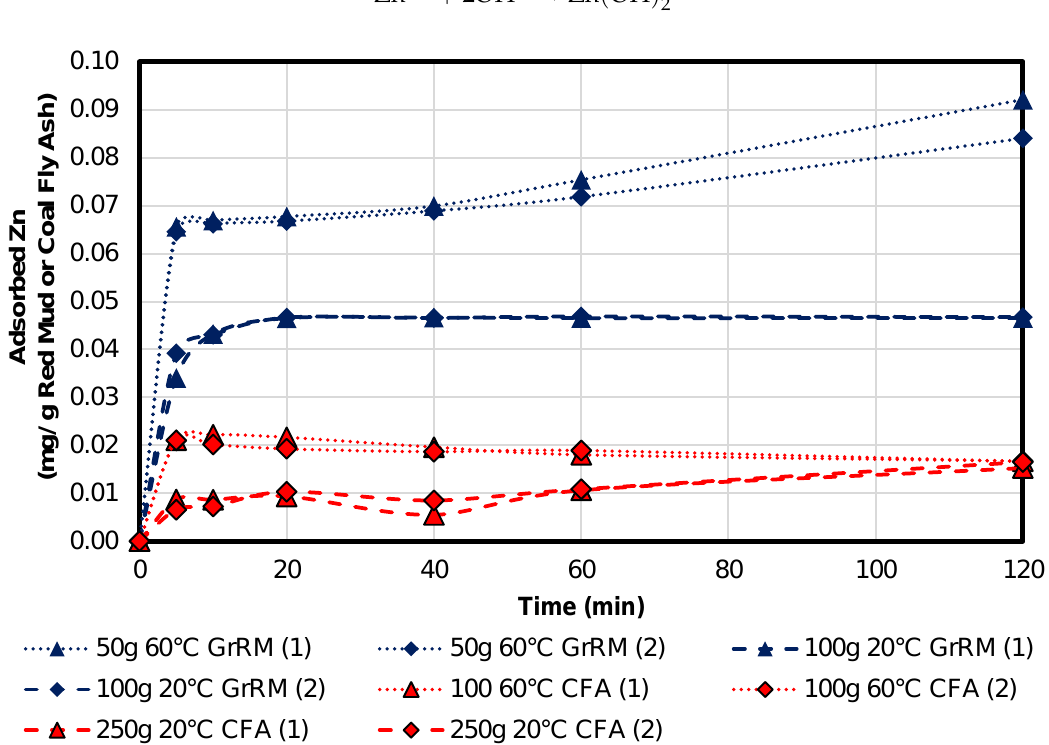
Figure 13. Kinetics of zinc adsorption for Greek red mud and coal fly ash [mg/g]. Table 8. Kinetics of zinc adsorption for Greek red mud and coal fly ash.